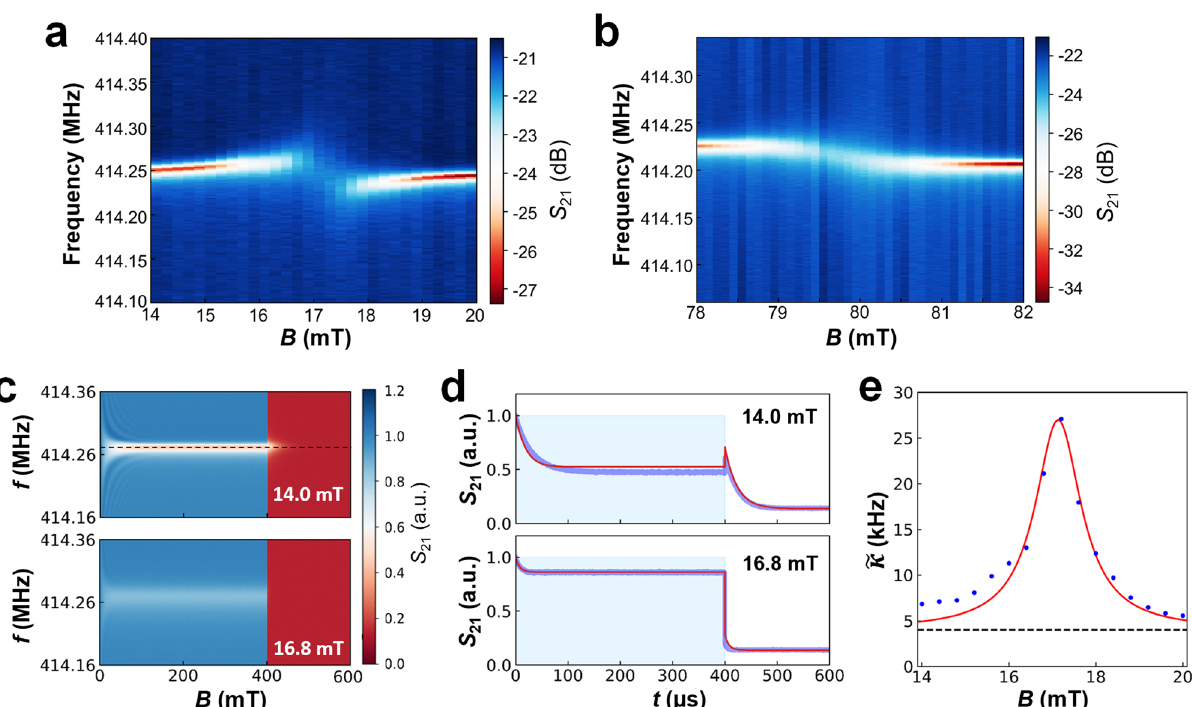
Fig. 4 Coupling cavity photons to nuclear spins. a Color plot of the microwave transmission showing the resonance of a f r = 414 MHz superconducting lumped-element resonator (LER) to the 1, 2 nuclear spin transition in [ 173 Yb(trensal)]. b Same as in a for the 2, 3 nuclear spin transition. Color scale bars indicate the amplitude of the transmitted signal in relation to the input signal on a logarithmic scale. c Time and frequency dependence of the transmission through the device normalized to the transmission of the bare readout line (see color scale bar on the right-hand side) and measured near the resonance of a f r = 414 MHz LER following the application and removal of a 400 μ s long pulse through the readout transmission line. The two plots show the behavior observed in and out of resonance with the 1, 2 nuclear spin transition in [ 173 Yb(trensal)]. d Charging and discharging of the resonator were measured at constant driving frequencies near ~ f r and for the same magnetic fi elds. Dots are experimental results and lines are fi ts for a resonator with an effective photon decay rate ~ κ (see Supplementary Note 4, in particular, Supplementary Eqs. (5 – 7)). e Magnetic fi eld dependence of ~ κ across the resonance with the 1, 2 nuclear spin transition. The solid line is a fi t based on the input-output theory described in Supplementary Note 4, which allows deriving the nuclear spin linewidth γ 1,2 ≃ 2.9 MHz. Error bars in e are smaller than the data point size. They have been determined from the Jacobian matrix obtained from the fi ts based on Supplementary Eqs. (5 –